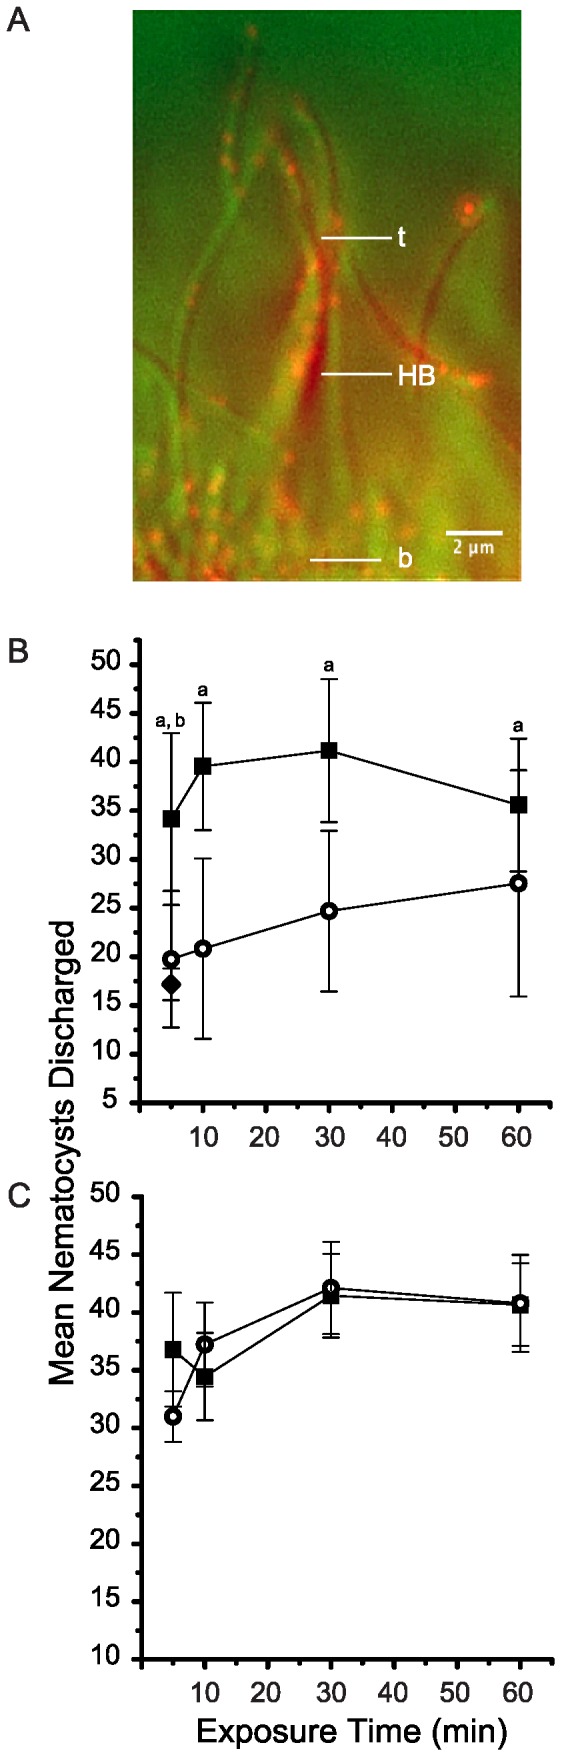
CDH23 immunocytochemistry and effects of CDH23 antibodies on vibration sensitivity in Nematostella vectensis.(A) Affinity purified CDH23 antibodies label stereocilia of a hair bundle (HB) with punctate fluorescence. The tip (t) and base (b) of the hair bundle are indicated. The merged image of a hair bundle is shown in transmitted light by oblique contrast (assigned green) and epifluorescence microscopy for CDH23 immunocytochemistry (assigned red). Scale bar  = 2 µm. (B) Vibration sensitivity was evaluated by means of a bioassay based on counting nematocysts discharged into test probes touched to tentacles in the presence of nearby vibrations at a key frequency. Vibration sensitivity was tested at intervals after adding 0.1 nM CDH23 antibodies (final concentration) to the seawater containing intact anemones. The mean number of nematocysts counted per field of view at 400× (±SEM, n = 10–15) is plotted (open circles). Data also are plotted for healthy, vibrating controls (closed squares) and non-vibrating controls (closed diamond) for which the animals were not exposed to exogenously supplied antibodies. (C) Vibration sensitivity was tested at intervals after adding 0.1 nM TRPA1 antibodies (final concentration) as an antibody-loading control. The mean number of nematocysts counted per field of view at 400× (±SEM, n = 5–6) is plotted (open circles). Data also are plotted for healthy, vibrating controls (solid squares). aSignificant difference in the mean number of nematocysts discharged between vibrating controls and 0.1 nM CDH23 antibody-treated specimens and bsignificant difference between the mean number of nematocysts discharged between the vibrating controls and non-vibrating control (p<0.05).